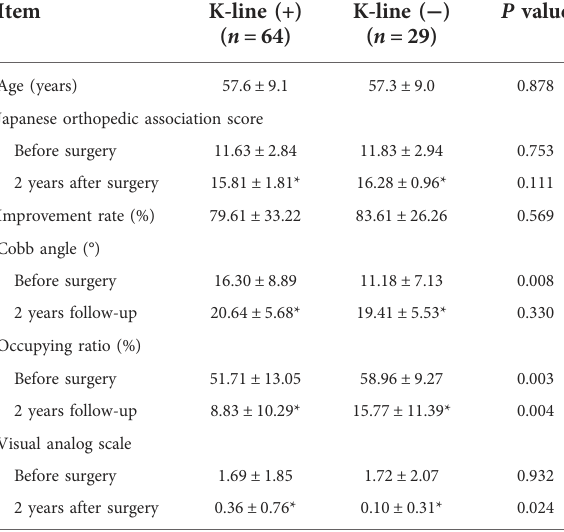
TABLE 2 Clinical data according to the K-line classi fi cation in neutral position.